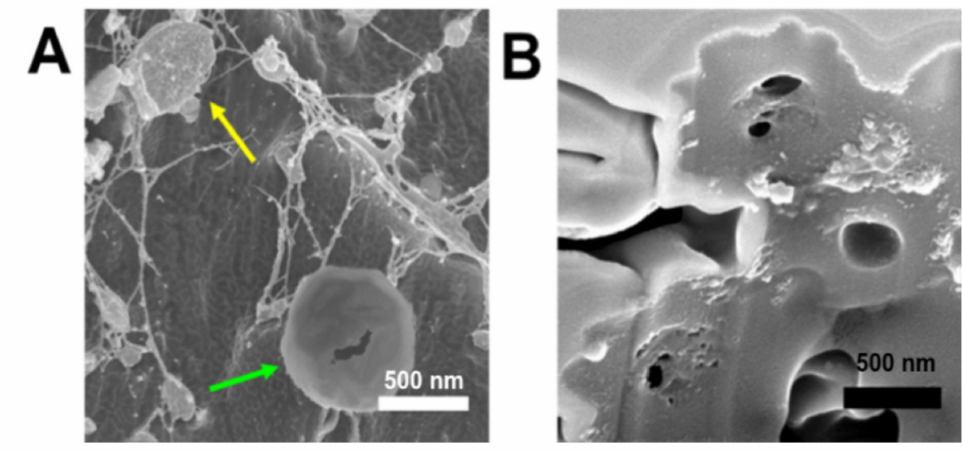
Figure 5. ( A ) Cryo-SEM micrograph of preformed HByp4-Fe(II) structures treated with EDTA (1 mM, 60 min). ( B ) SEM micrograph of HByp4-Fe(II) assemblies ablated with an ion beam. Scale bar: 500